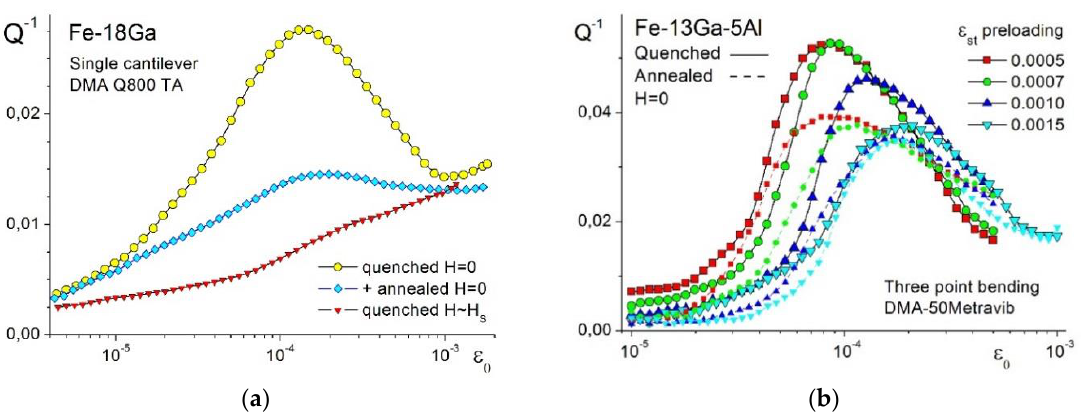
Figure 14. Influence of heat treatment and magnetic field ( a ) and static preloading for as-quenched (solid line, bigger signs) and annealed (dash line, smaller signs) alloys ( b ) on ADIF curves. Damping capacity strongly depends on the measuring method; as a rule of thumb, it is higher if free decay vibrations are used and lower in case of forced vibrations [38].